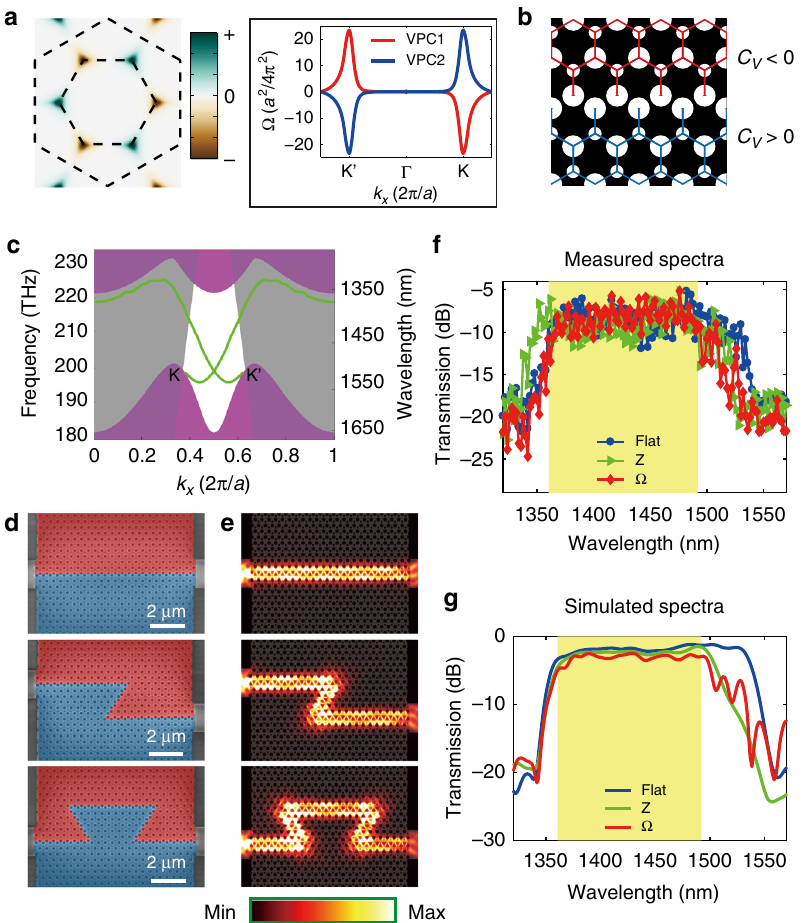
Fig. 2 Valley-dependent topological edge states in silicon-on-insulator (SOI). a Distribution of TE1 Berry curvature for VPC1, which is localized near the corners of the fi rst Brillouin zone. The valley-dependent Berry curvature has opposite sign to each valley. The inset plots the Berry curvature along k y = 0 direction, indicating that the Berry curvature of VPC2 (blue) has inversed distribution to that of VPC1 (red). b Schematic of the valley-dependent topological interface constructed by two types of valley photonic crystal (VPC) slabs. The VPC1 (red) and VPC2 (blue) attribute to different topological phases, characterized by the sign of their valley Chern index C V . c Dispersion of the valley-dependent edge states (green lines) for the bearded-stack interface. Purple region: projection TE-like band. Translucent gray region: light cone of silicon dioxide substrate. d Top-view scanning-electron-microscope images of the fabricated samples, including fl at, Z-shape, and Ω -shape topological interfaces. e Simulation of electromagnetic energy intensities for the three distinct shape interfaces at z = 0 plane ( λ = 1430 nm). The Z- ( Ω -) shape interface with two (four) 120 o bends shows that light can smoothly propagate around the corners. f Measured and g simulated transmission spectra for the fl at (blue), Z-shape (green), and Ω -shape (red) interfaces, respectively. The yellow regions correspond to the TE-like gap of SOI VPC. All of the spectra in the bandgap maintain the fl at-top high transmittance, even for a sharp-bending geometry (green and red). This intriguing property indicates broadband robust transport in the frequency interval from 1360